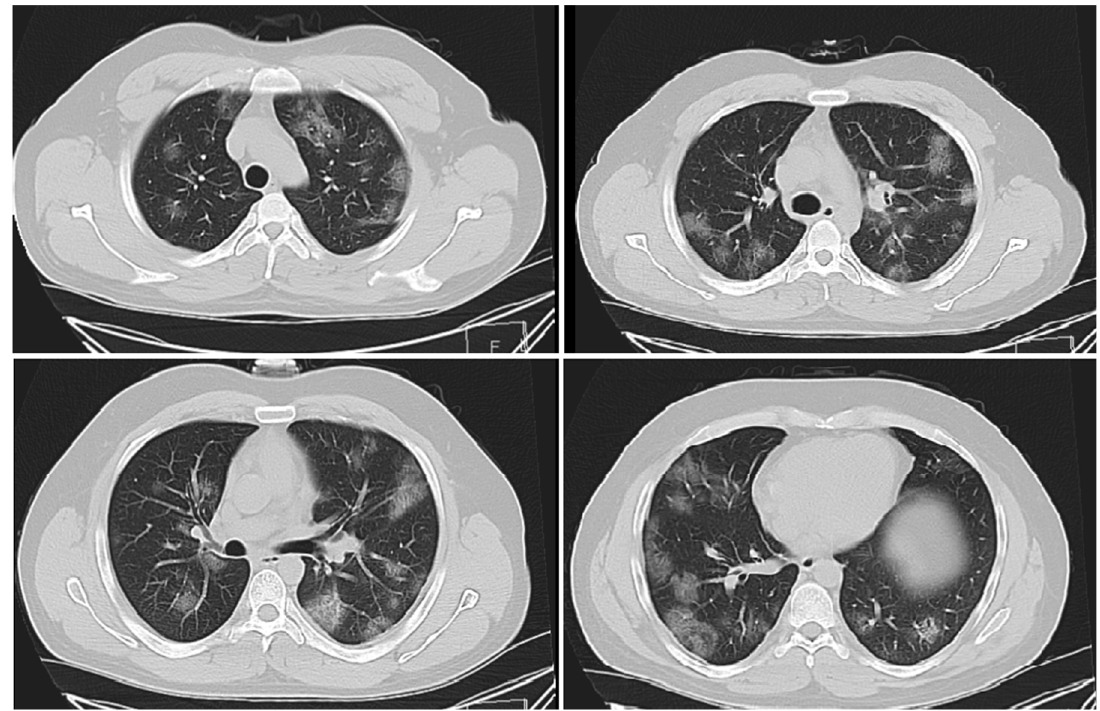
Figure 7. Chest MDCT, lung window, axial plane: Bilateral multi-lobar multifocal ground glass opacities with random peripheral distribution are seen. Some areas of peribronchovascular opacities are also seen with no lymphadenopathy and no pleural effusion.